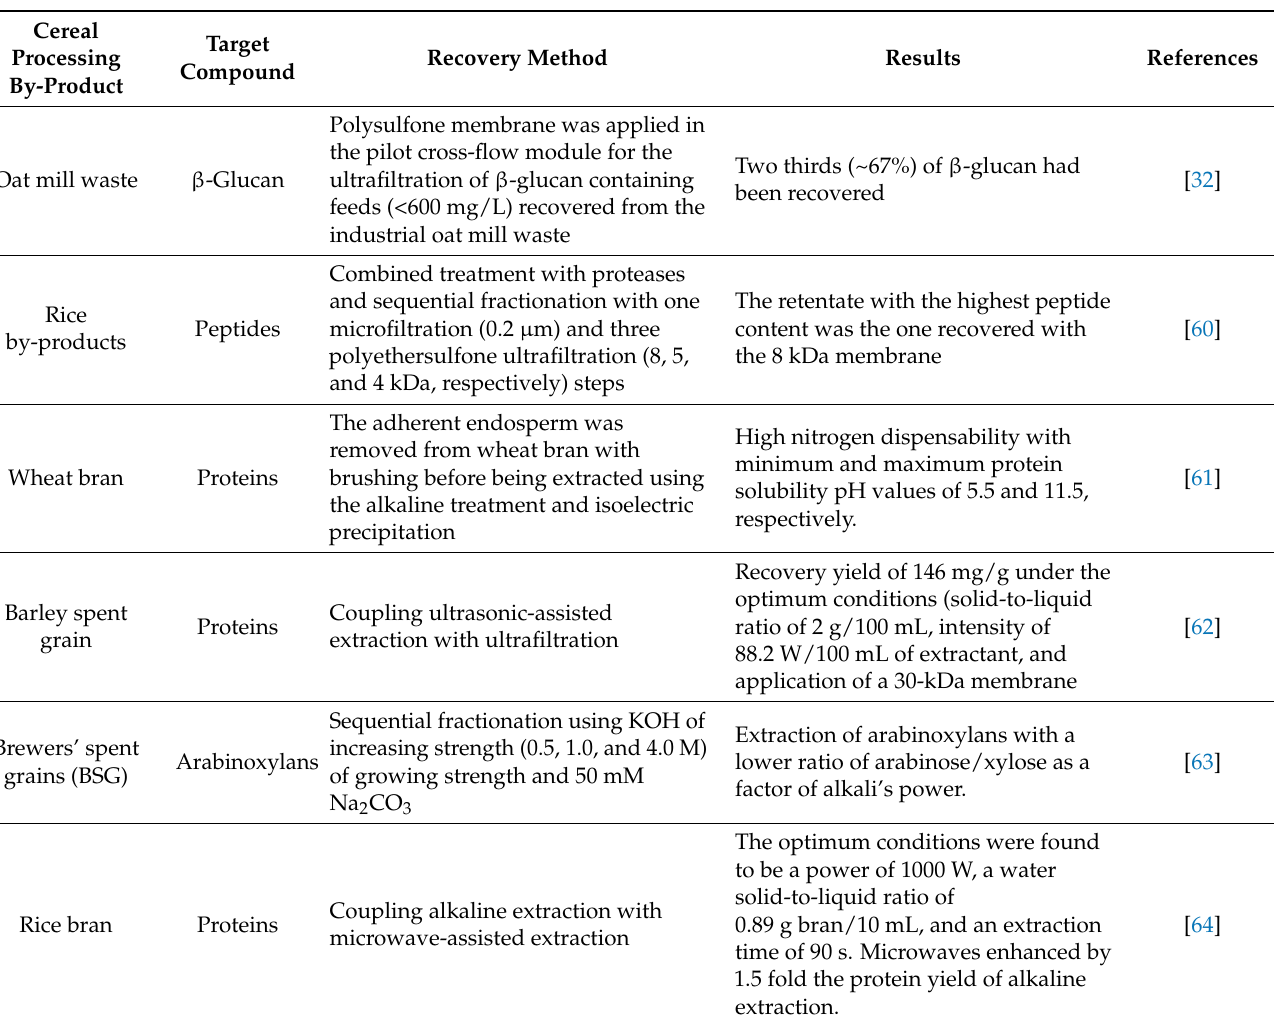
Table 3. Different approaches and technologies for the recovery of valuable compounds from different cereal processing